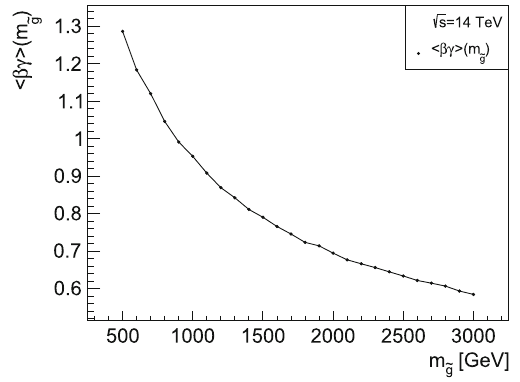
Fig. 64 AveragevalueoftheLorentzfactor βγ ofgluinosasafunction of the gluino mass m ˜ g